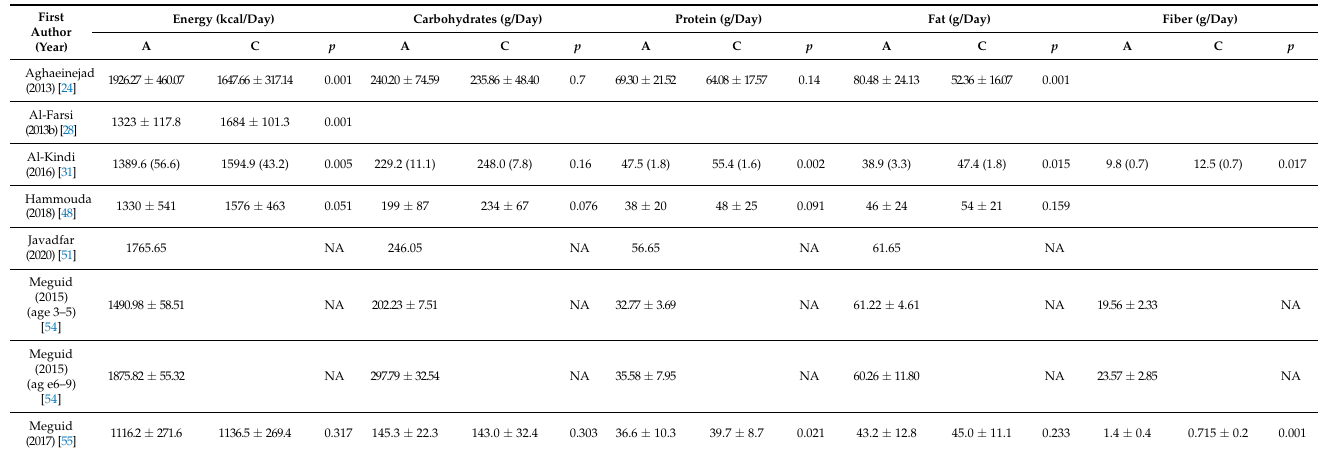
Table 5. Energy, macronutrient, and fiber intakes data of children with autism spectrum disorder and controls in the MENA region.